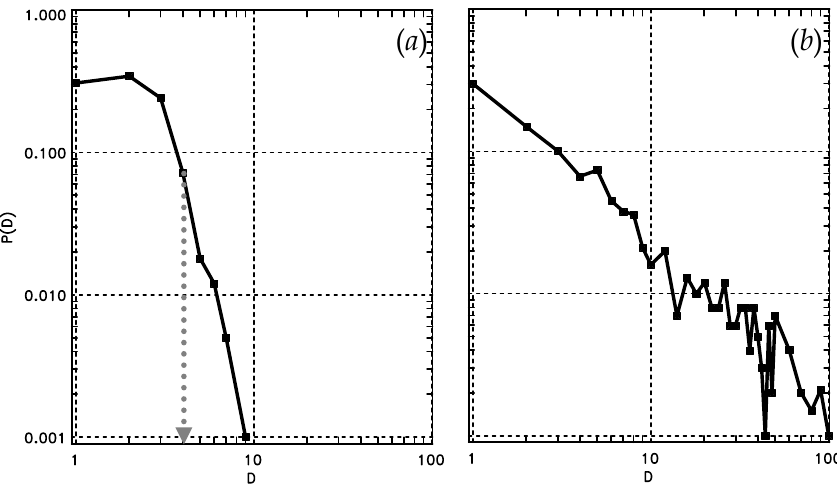
Fig. 5. Distribution functions of D n calculated with NN = 3 and M I = M O = 50 for the time series generated by the synchronized Lorenz attractor with 1/ f -noise contamination. (a) Small noise amplitude ( ε = 0 . 5 > σ 1 /f = 0 . 4). Distribution function drops rapidly to zero at D = 4. (b) Large noise amplitude ( ε = 0 . 5 (cid:28) σ 1 /f = 15). The power shape of the distribution function indicates the absence of finite embedding dimensions at the small